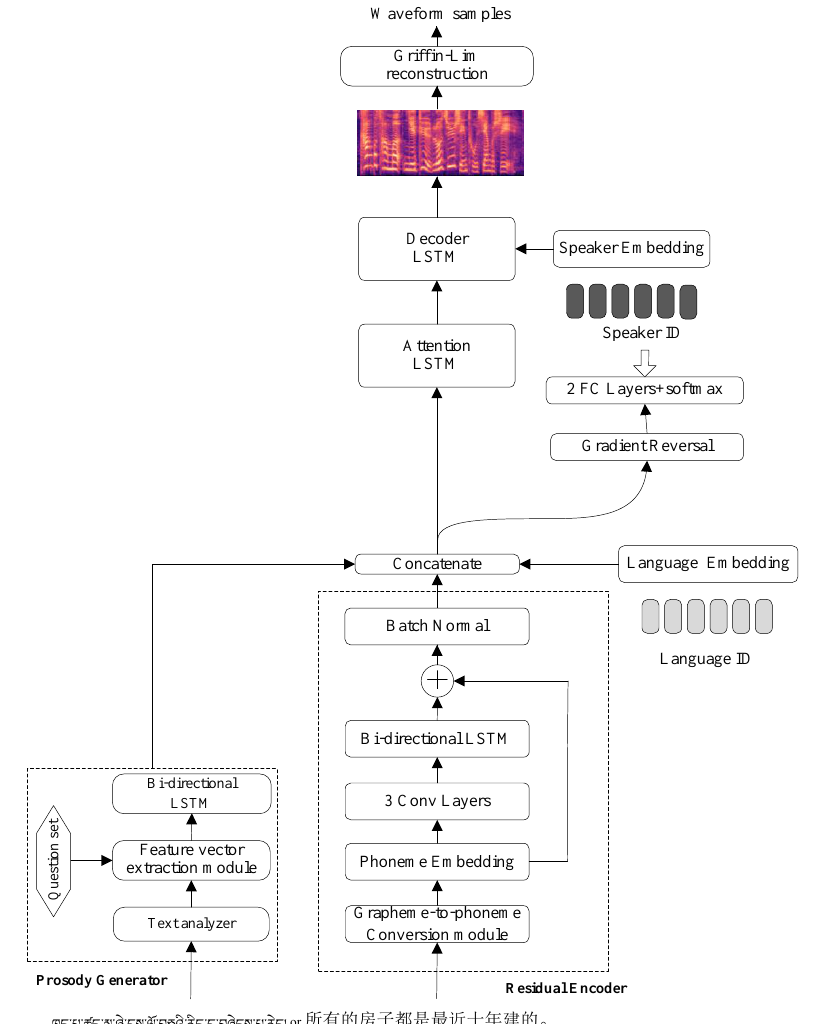
Figure 2. The shared encoder Mandarin-Tibetan cross-lingual TTS. The shared residual encoder handles phoneme sequences from different languages with explicit language embedding. In addition, a prosody generator is designed to extract the prosodic information from a sentence. The prosody generator includes a text analyzer, a feature vector extraction module, a question set, and a hidden feature extraction module. In the figure, the input is a Tibetan sentence (left) or a Chinese sentence (right), which means that all houses have been built in the last ten